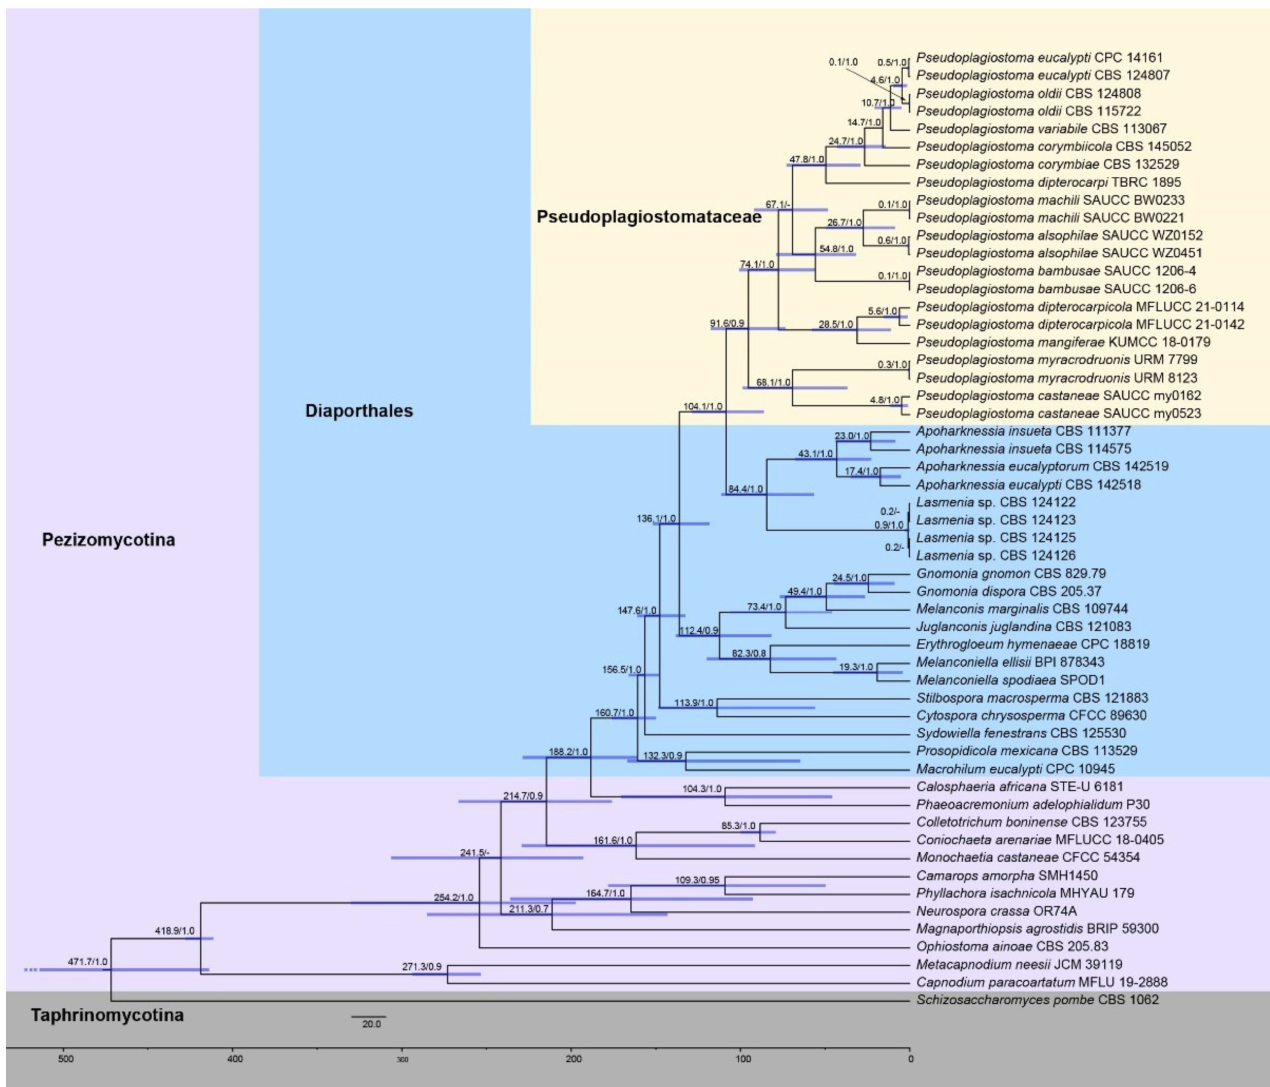
Figure 2. An estimated divergence of Pseudoplagiostomataceae generated from molecular clock analyses using a combined dataset of ITS, LSU, rpb2 , tef1 α , and tub2 sequences. Estimated mean divergence time (Mya) and posterior probabilities (PP) > 0.7 are annotated at the internodes. The 95% highest posterior density (HPD) interval of divergence time estimates is marked by horizontal blue